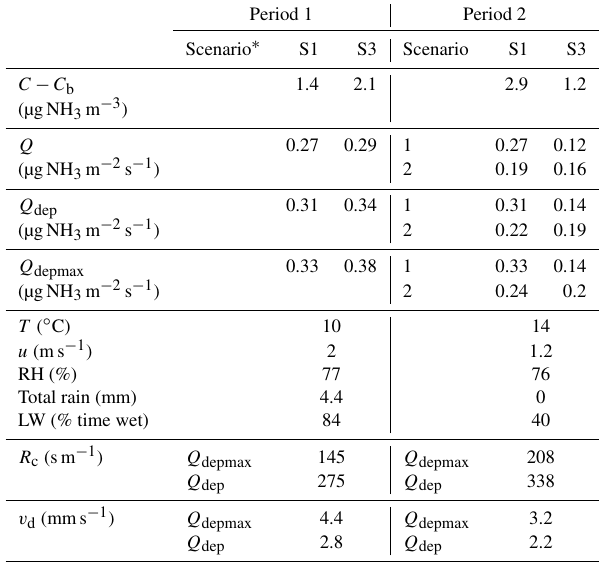
Table 2. Summary table of measurement and modelling